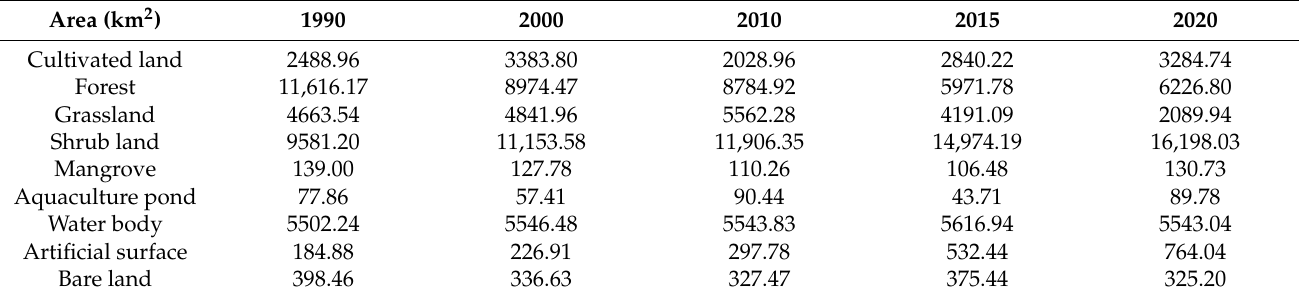
Table A2. Area statistics of land cover types in Timor Island between 1990 and 2020.